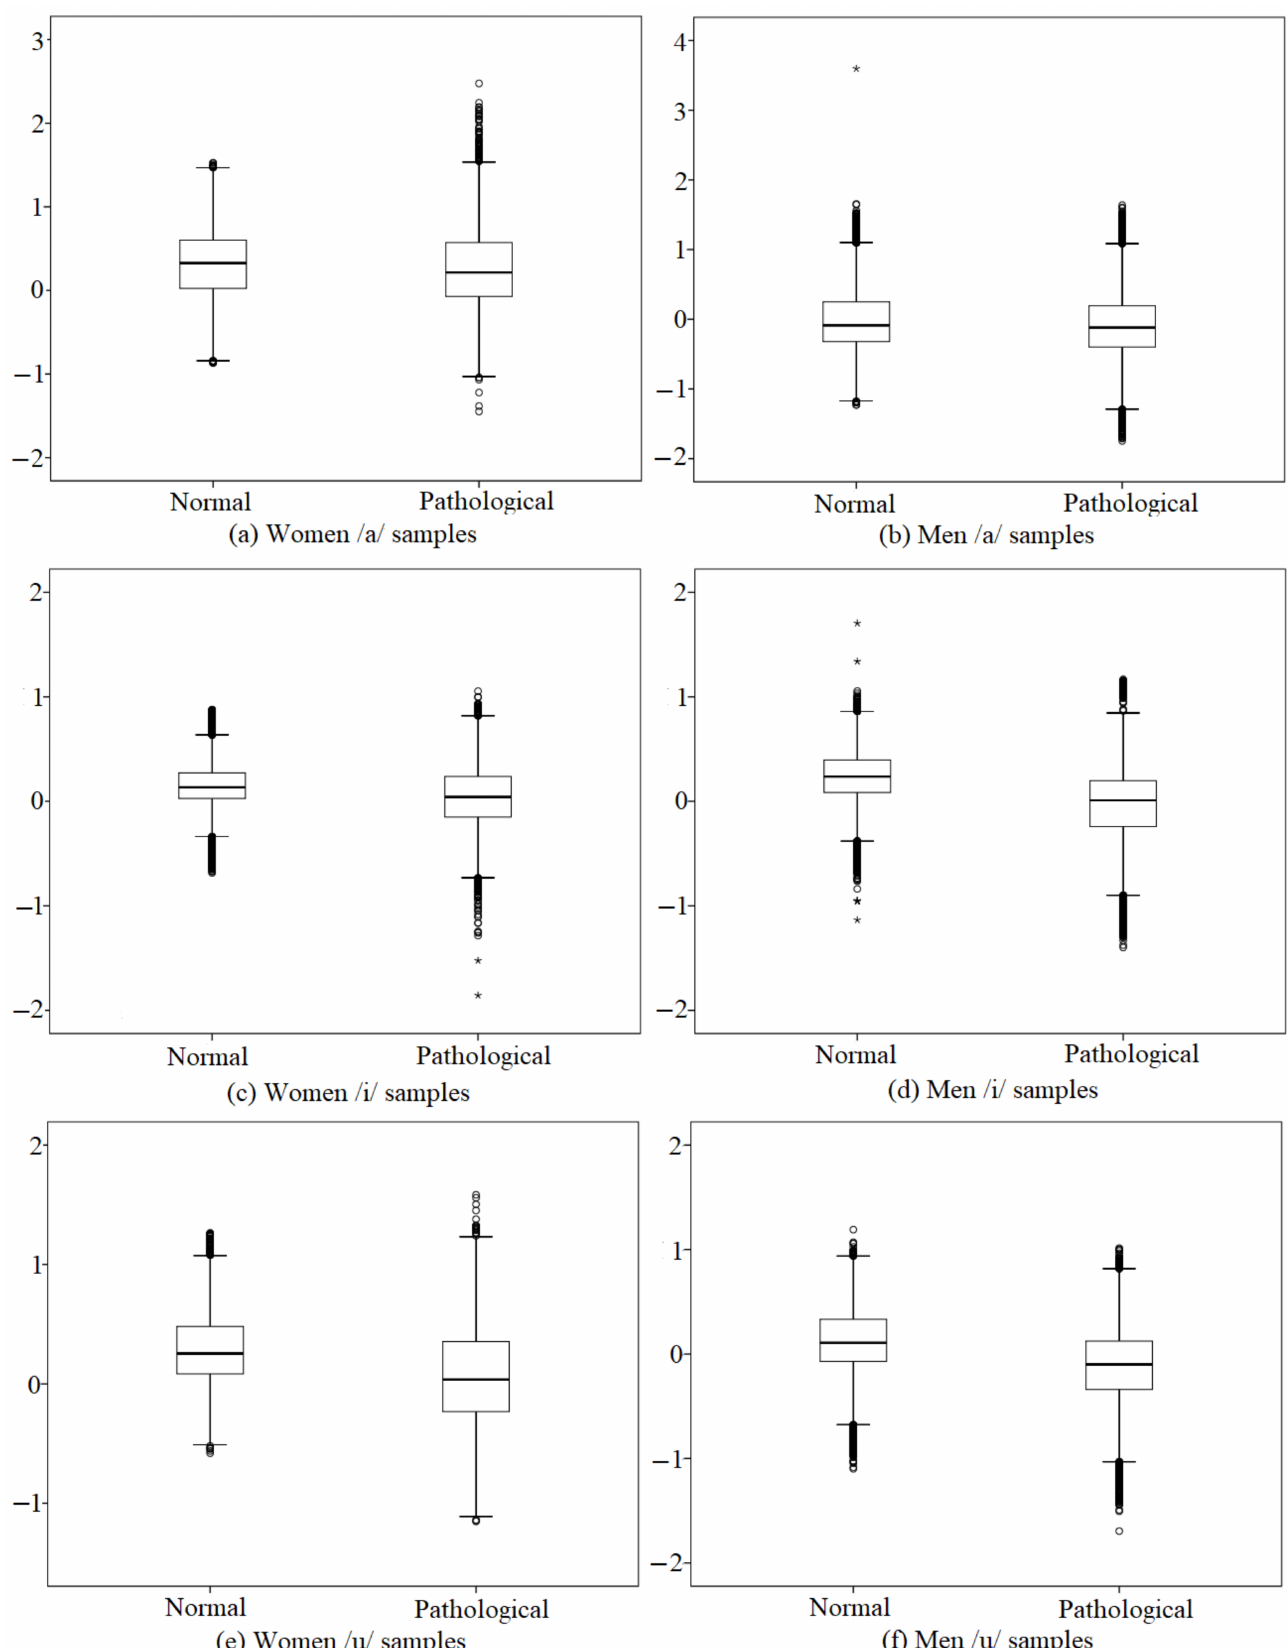
Figure 4. Distributions of normalized skewness in each vowel (o: outlier, *: extreme